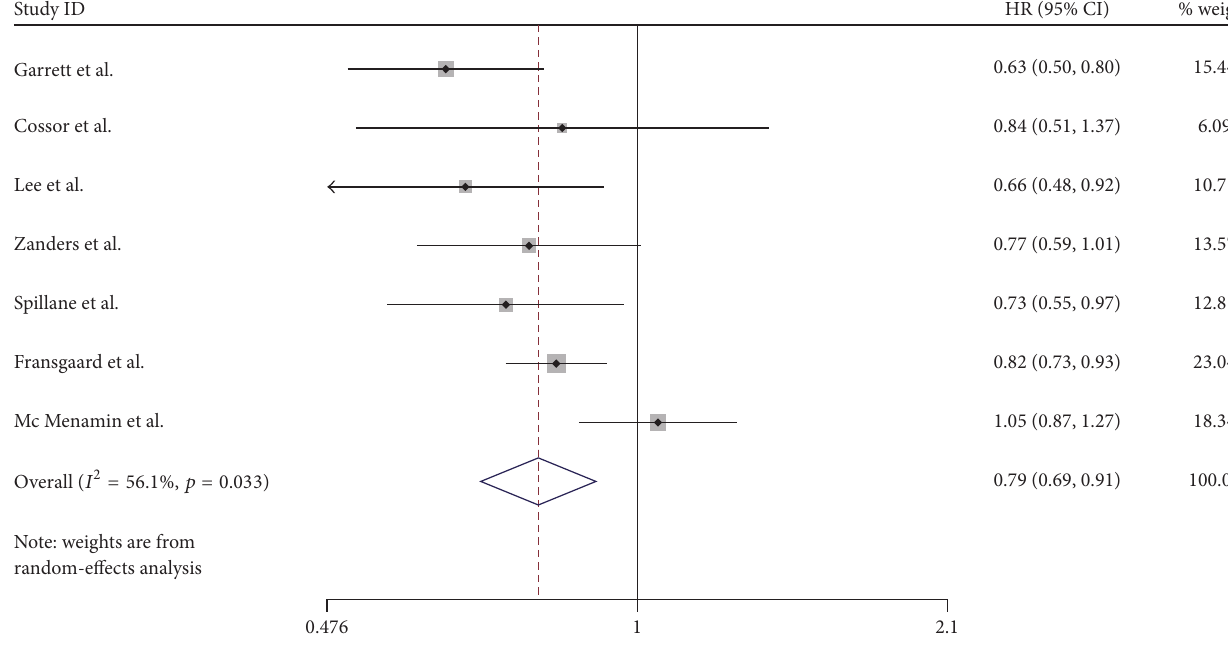
Figure 2: Forest plot of the association between metformin use and colorectal cancer OS.